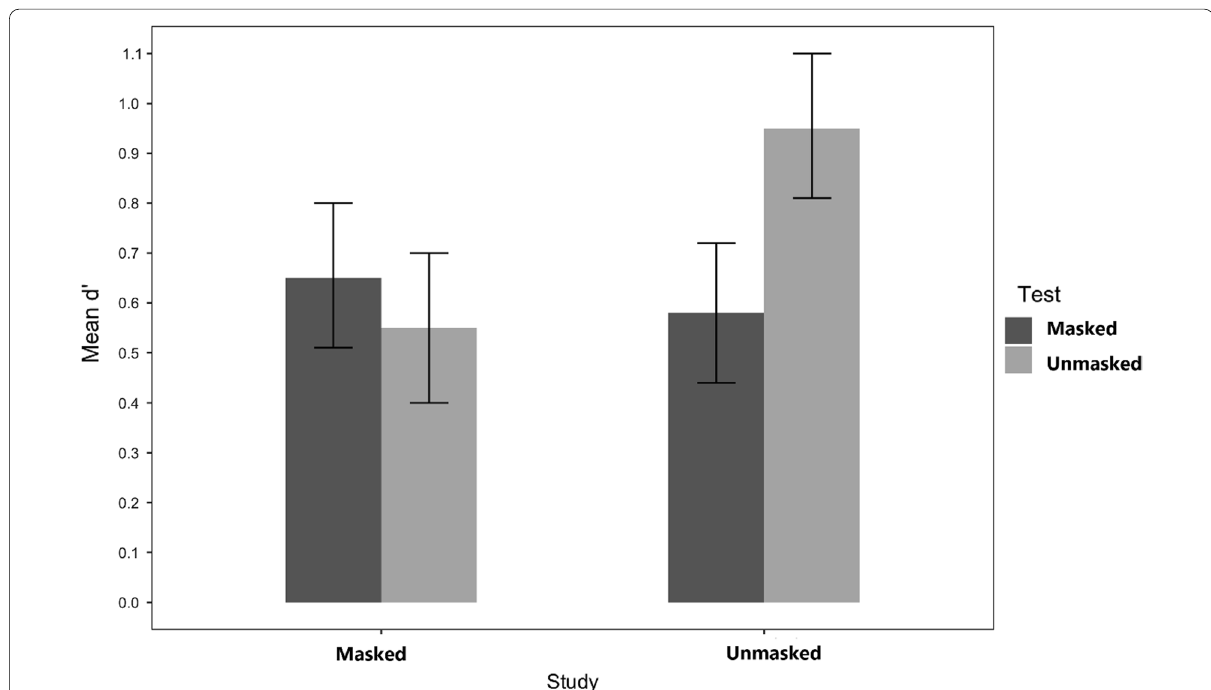
Fig. 2 Experiment 1: Sensitivity d’. Note . Mean response sensitivity for faces studied with and without a mask and subsequently tested with or without a mask, in Experiment